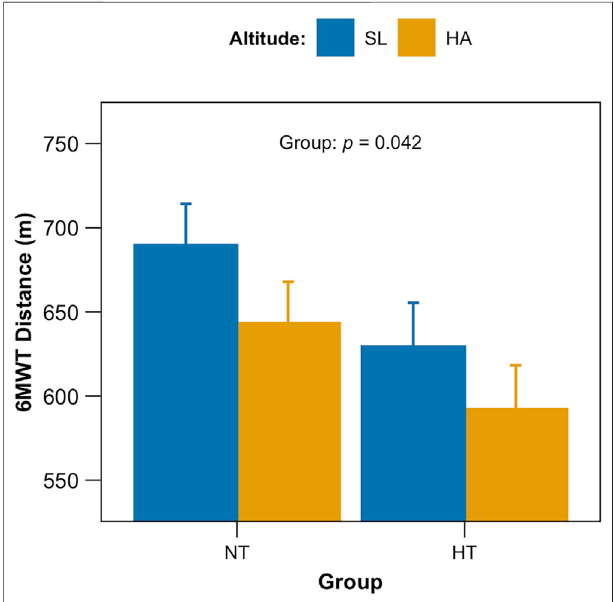
FIGURE 3 | Six-minute walk tests (6MWT) results. Total distance covered (in meters) after the 6MWT for both groups (NT, non-hypertensive; HT, hypertensive) at both altitudes ( p = 0.042 for